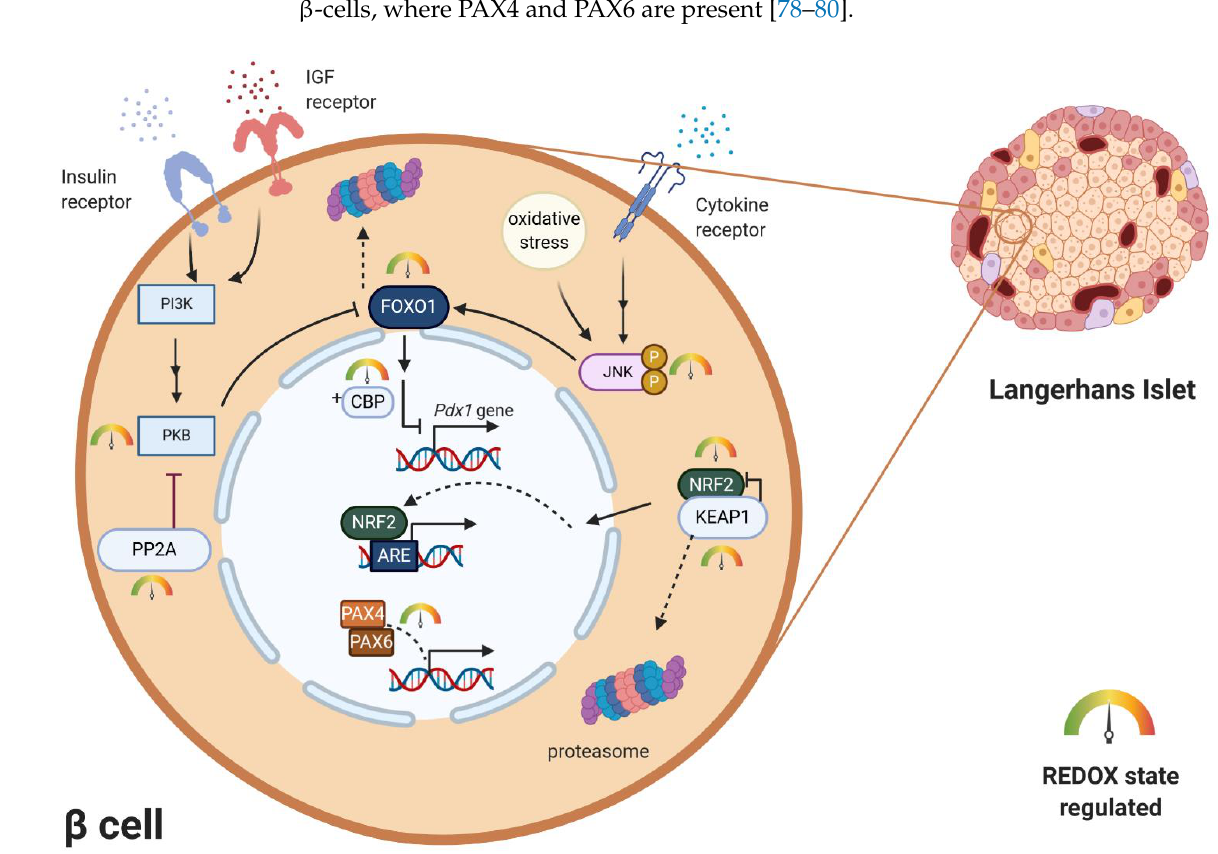
Figure 3. Examples of redox regulation of specific transcription factors. Pdx1 gene is negatively regulated by redox-sensitive transcription factors FOXO and CBP. Localization and transcription activity of FOXO is negatively regulated by PI3K- PKB/AKT signaling and positively regulated by the JNK signaling pathway. Activated by oxidative stress/cytokine stimuli, JNK enables FOXO nuclear localization. Concurrently redox-sensitive PKB is inhibited by H 2 O 2 -induced intramolecular disulfide bond formation. Redox sensitive NRF2/KEAP1 system regulates expression of key antioxidant enzymes upon ARE region. Under oxidizing conditions, the cytoplasmic complex dissociates, NRF2 enters the nucleus and functions as a transcription factor. Redox-sensitive cysteines in PAX transcription factors directly regulate their DNA-binding